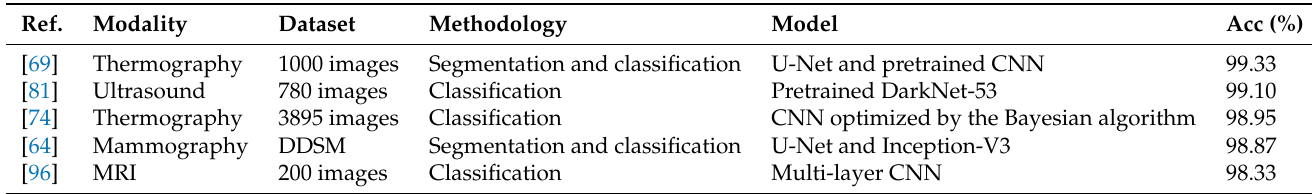
Table 4. Comparison of performance metrics of the best models. Acc: Accuracy.